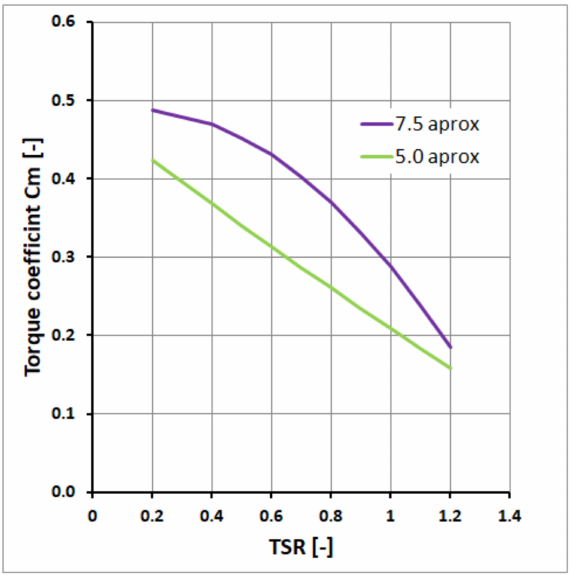
Figure 12. Approximated torque coefficient dependence on wind